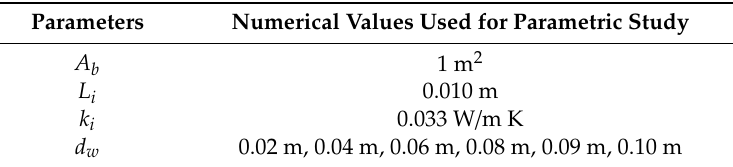
Table 7. Modified still parameters used for parametric study.